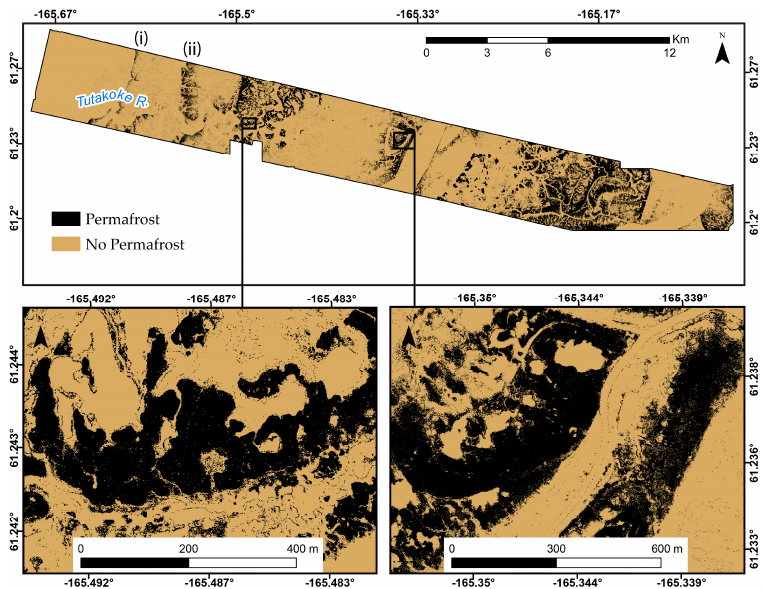
Figure 11. Permafrost map from the integrated RT classification trained with thaw-depth sample points along transects (same training as logistic regression). The insets show more detail in areas of relative high elevation ( left ) and areas of relative low elevation ( right ). Transitions between the mudflat and active floodplain deposit (i), and active and inactive floodplain deposits (ii) are also shown. Remote Sens. 2018 , 10 , x FOR PEER REVIEW 13 of 20